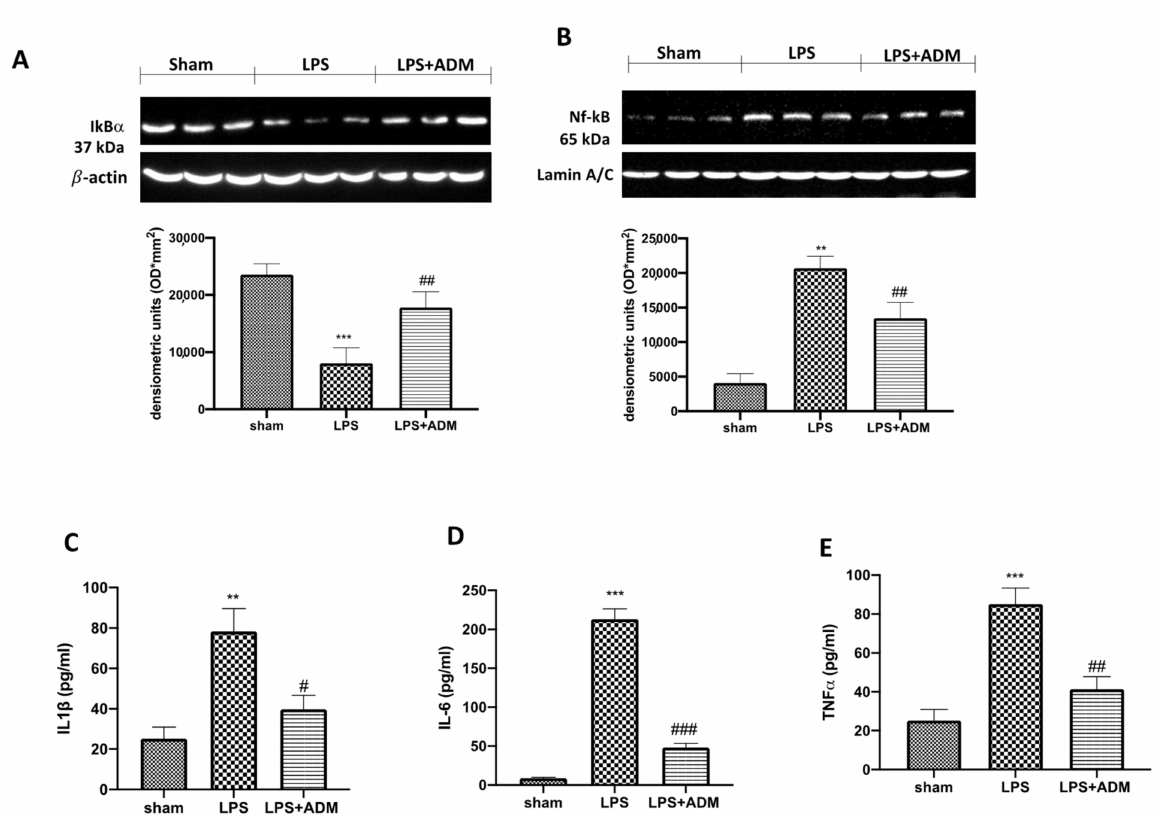
Figure 8. Western blot analysis for NF- κ B ( B ) and I κ B- α ( A ). Levels of inflammatory cytokine in lung tissues: IL-1 β ( C ) IL-6 ( D ), TNF- α ( E ). A demonstrative blot of lysates for NF-kB and I κ B- α with a densitometric analysis for all animals is shown. Data are expressed as the mean ± SEM of N = 6 mice/group. ** p < 0.01 vs. sham; *** p < 0.001 vs. sham; # p < 0.05 vs. LPS; ## p < 0.01 vs. LPS; ### p < 0.001 vs.